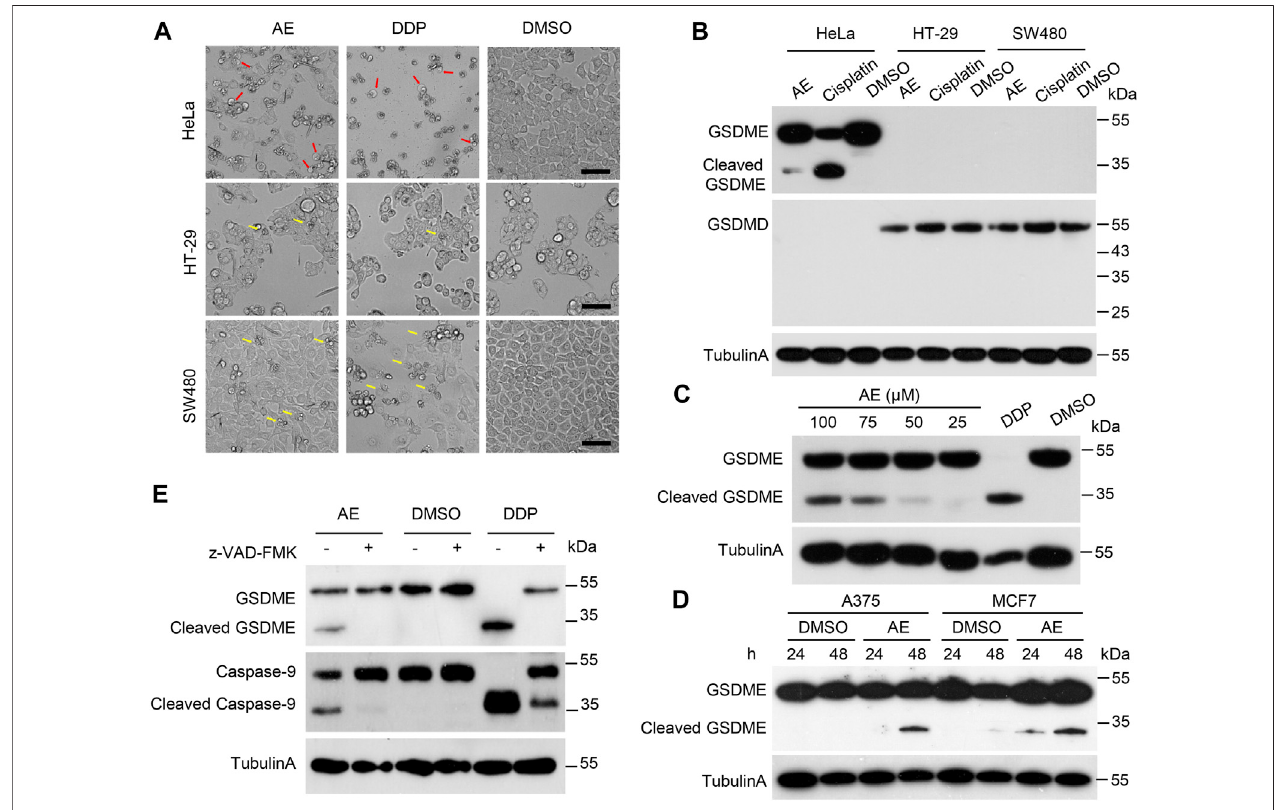
FIGURE3| AEactivatedthecaspase9/caspase3/GSMDEaxisandinducedpyroptosisofHeLacells. (A) TheeffectsofAEonthemorphologyofHeLacells.HeLa, HT-29, and SW480 cells were treated with AE (50 μ M) or DDP (5 mg/L) for 16 h. Shown are representative microscopic images of cells. The red arrows indicate the pyroptoticcells,andtheyellowarrows represent theapoptoticcells.Scalebar,100 μ m. (B) Immunoblottingdetection ofGSDMscleavageinAE-treated HeLacells. Cell lysates in (A) were prepared and subjected to immunoblotting analysis with the indicated antibodies. (C) Immunoblotting detection of GSDMs cleavage in HeLa cells in AE-dosed manner. (D) Immunoblotting detection of GSDME cleavage in AE-treated A375 and MCF7 cells. Cells were cultured with AE (50 μ M) for 24 or 48 h, followedbyimmunoblottinganalysiswiththeindicatedantibodies. (E) InhibitionofcaspaseactivityreversestheAEmediated-GSDMEcleavage. HeLacellsweretreated with AE (50 μ M) or DDP (5 mg/L) for 24 h, followed by immunoblotting analysis. Caspase inhibitor z-VAD-FMK was added at 2 h before AE or DDP treatment. Data of immunoblots are representative of three independent